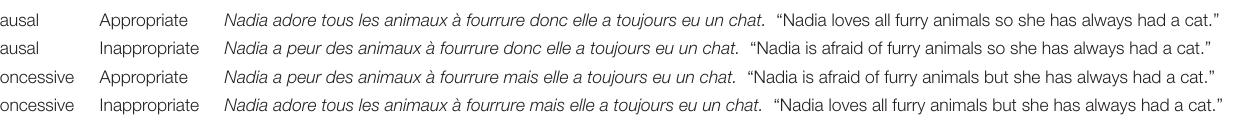
TABLE 3 | The four versions of an example of experimental item in Experiment 1.